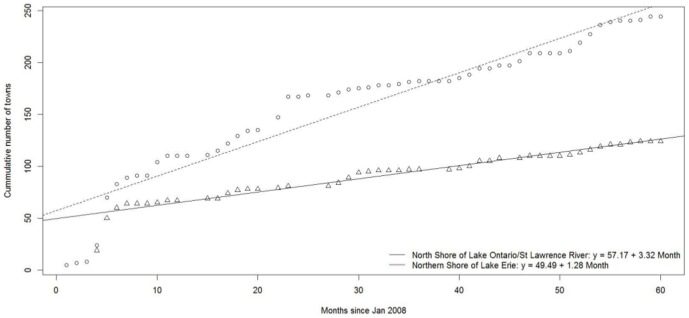
Rate of spread of Ixodes scapularis, measured in cumulative number towns with blacklegged ticks submissions along the northern shores of Lake Ontario/St. Lawrence River and Lake Erie, Ontario, Canada (2008–2012).* *Includes I. scapularis submitted from: human (n = 6,147), dog (1,961), cat (206), environment (24), white-tailed deer (6), horse (3) and other animals not specified or unknown (51).